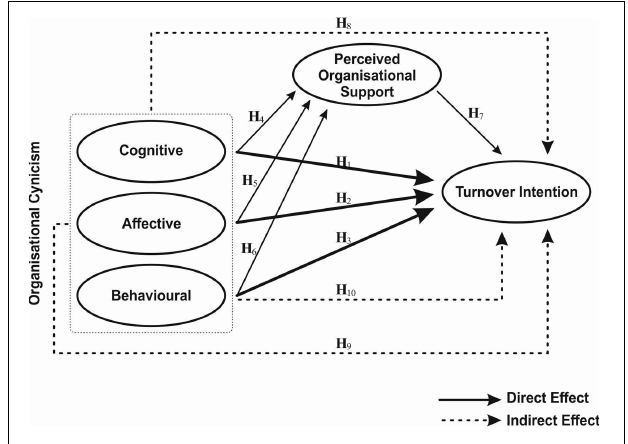
FIGURE 1 | Proposed model of organisational cynicism, perceived organisational support and turnover